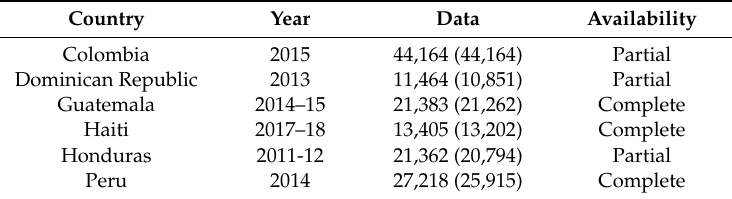
Table 1. Information of the countries selected for the analysis.